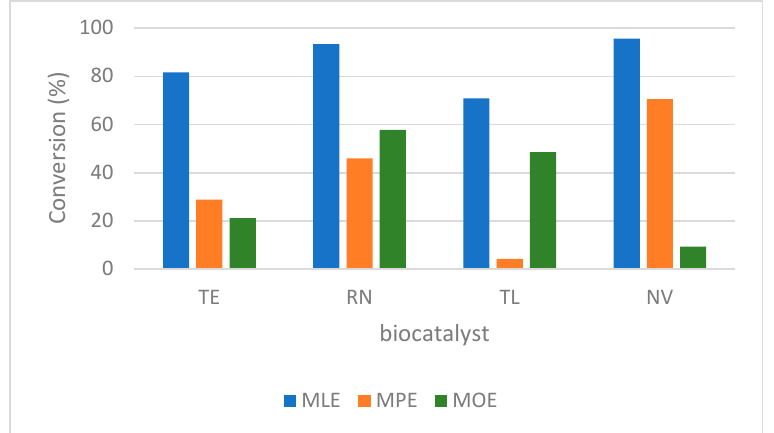
Figure 3. Influence of the FAME structure on the developed biocatalytic system. Experimental conditions: 1.58 mM FAME, L -menthol:FAME = 3:1 molar ratio, 1 mg/mL lipase biocatalyst in M:CA (I) reaction medium, 40 ◦ C temperature, 1000 rpm shaking, and 24 h reaction time. Triplicate measurements of the samples with maximum 18% RSD.